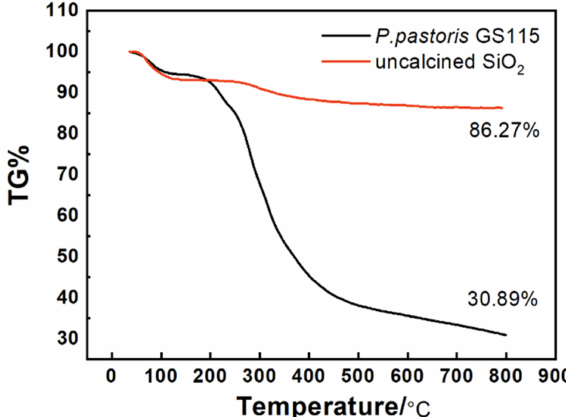
Figure A2. TG curves of P. pastoris GS115 and uncalcined SiO 2 (conditions: TEOS concentration